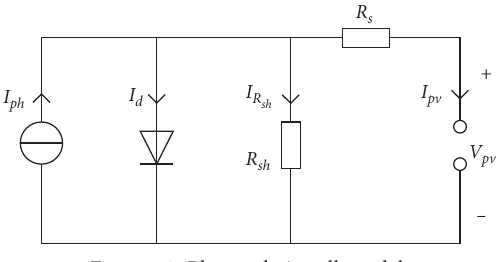
Figure 1: Photovoltaic cell